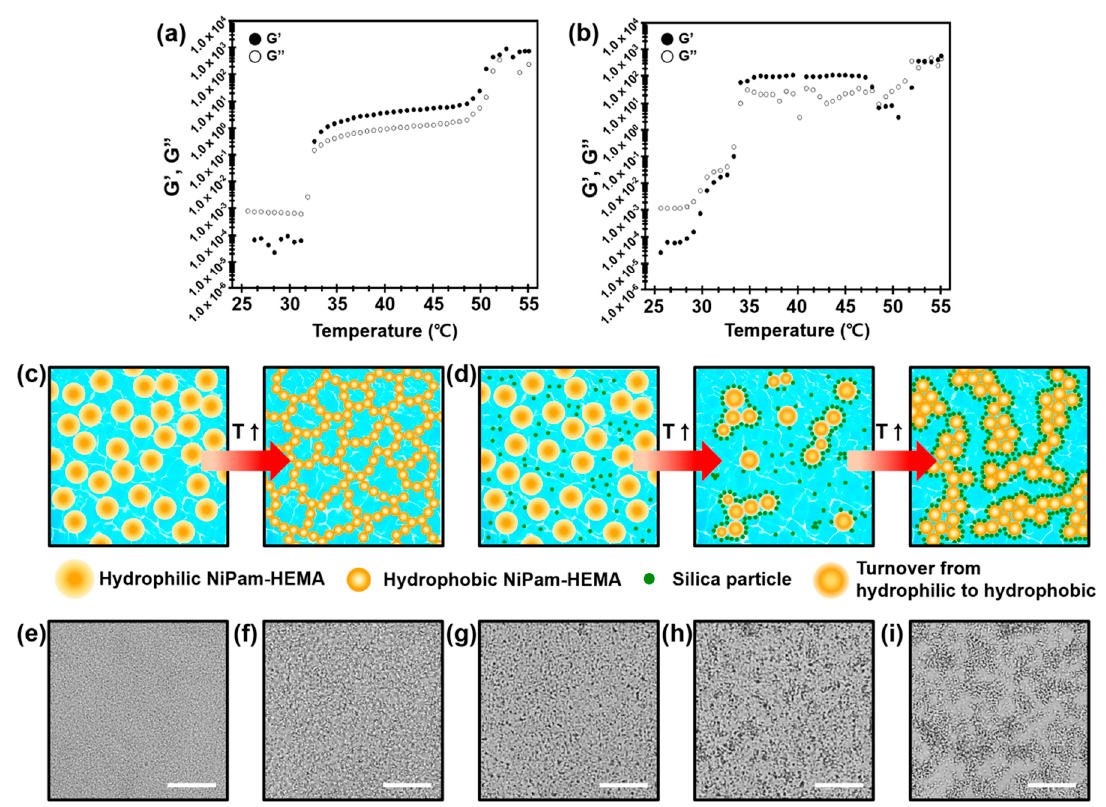
Figure 4. ( a , b ) Thermogelling behavior of 2.7 wt% p(NiPAm-co-HEMA) microgels with 7:3 of NiPAm:HEMA molar ratio at 0.17 M of NaCl and silica nanoparticle composite. A comparative study between ( a ) the neat p(NiPAm-co-HEMA) and ( b ) the mixture of the microgel and the silica nanoparticle of 1:1 weight ratio. ( c , d ) Schematics of gelation process of ( c ) a neat p(NiPAm-co-HEMA) microgel dispersion and ( d ) the p(NiPAm-co-HEMA) microgel–silica nanoparticle composite. Time-resolved microscopic images showing sol–gel transition of ( e , f ) a neat p(NiPAm-co-HEMA) microgels and ( g – i ) p(NiPAm-co-HEMA) microgel–silica nanoparticle composite.